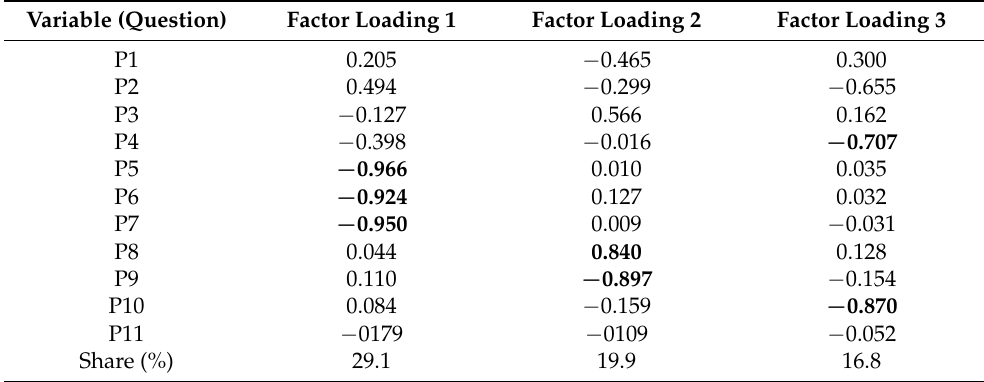
Table 1. Factor loadings of principal components for questions P1–P11 to assess function performance